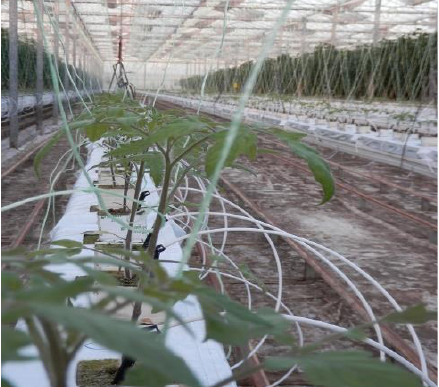
Figure 2. Application of the polymeric films with the encapsulated bioactive agents on tomato hydroponic crops cultivation.